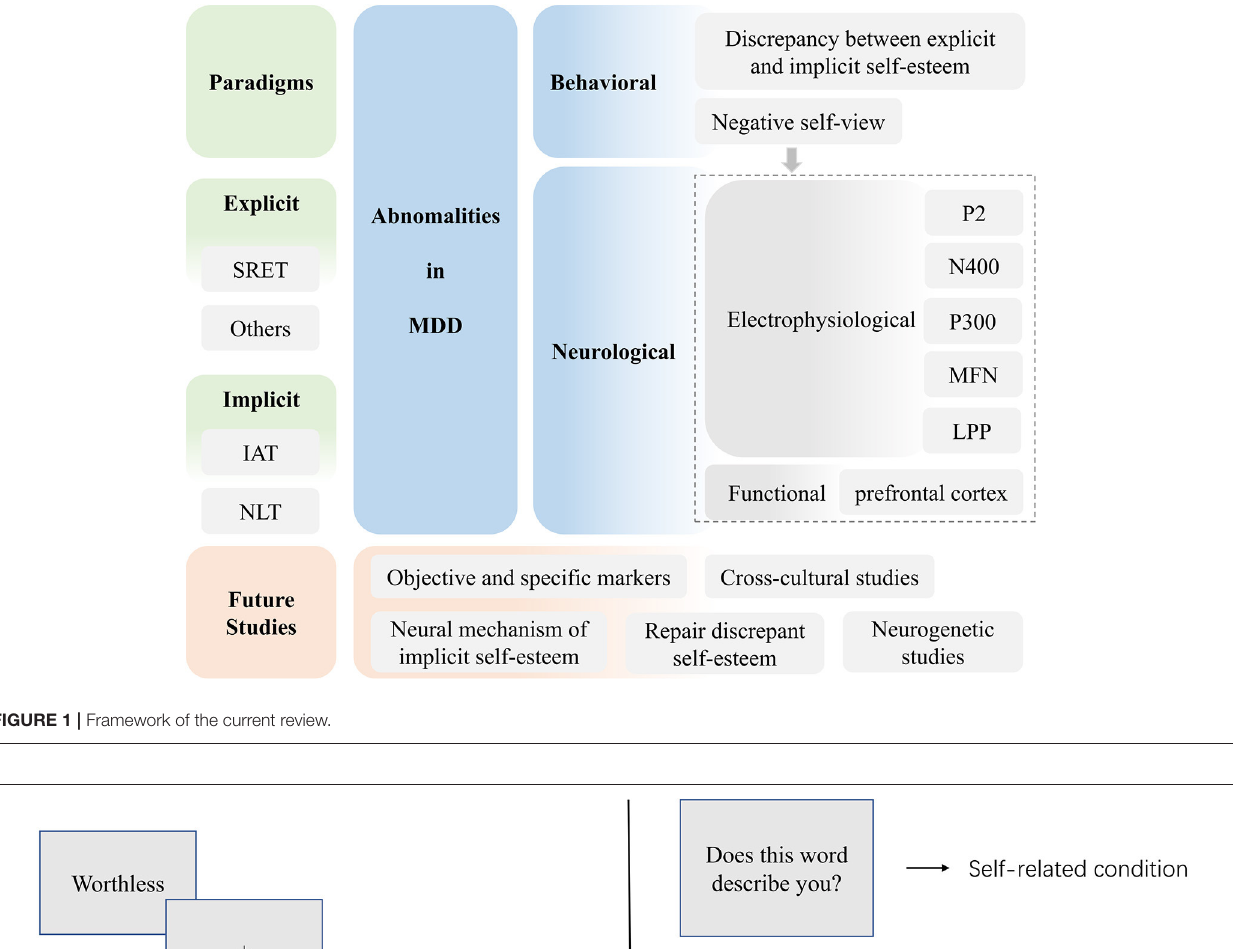
FIGURE 1 | Framework of the current review.